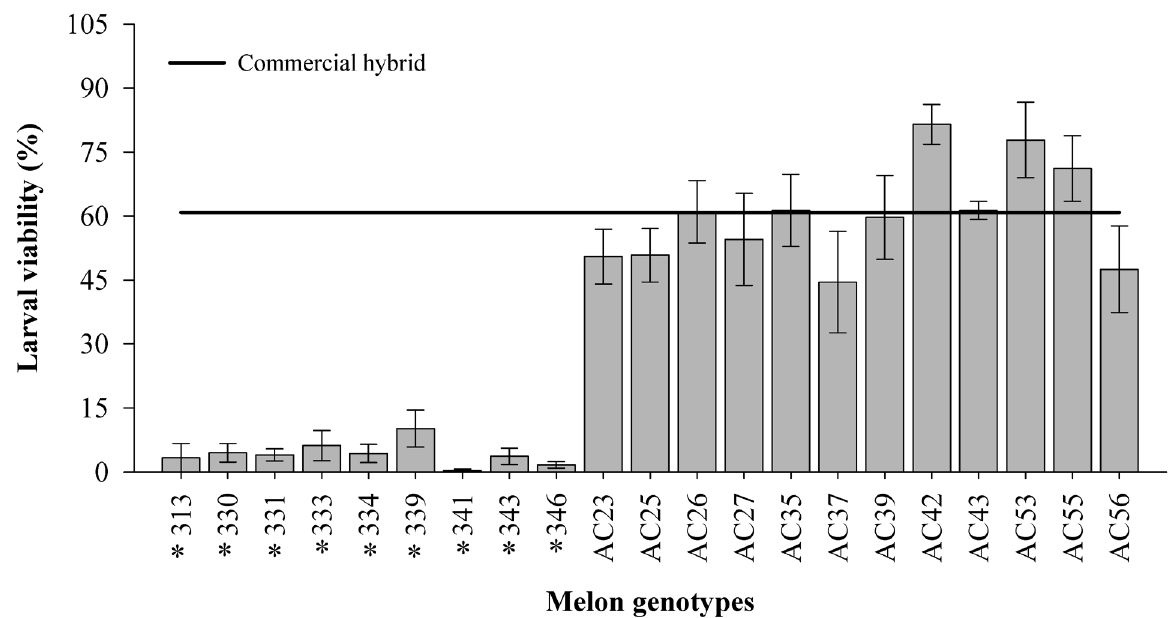
Figure 3. L. sativae larval viability in melon genotypes. Genotypes followed by asterisks indicates a significant difference in relation to the commercial hybrid by Dunnett’s test (α = 0.05). Line in bold (mean larval viability of the susceptible standard genotype), Bars (mean larval viability of genotypes with standard